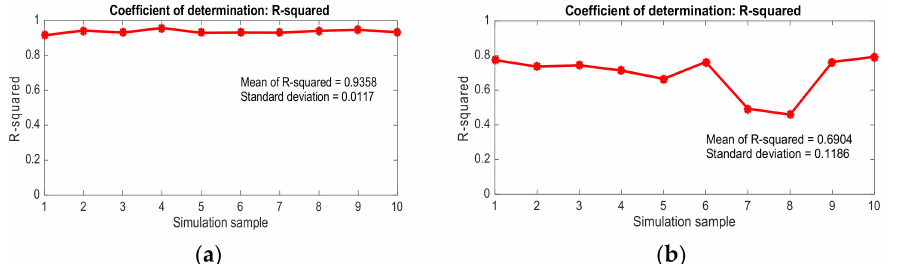
Figure 7. R 2 coefficients of amplitude PDF of SLC images against the Rayleigh model: ( a ) HPD: Gaussian; ( b ) HPD: Weibull. The PSD for both surfaces is